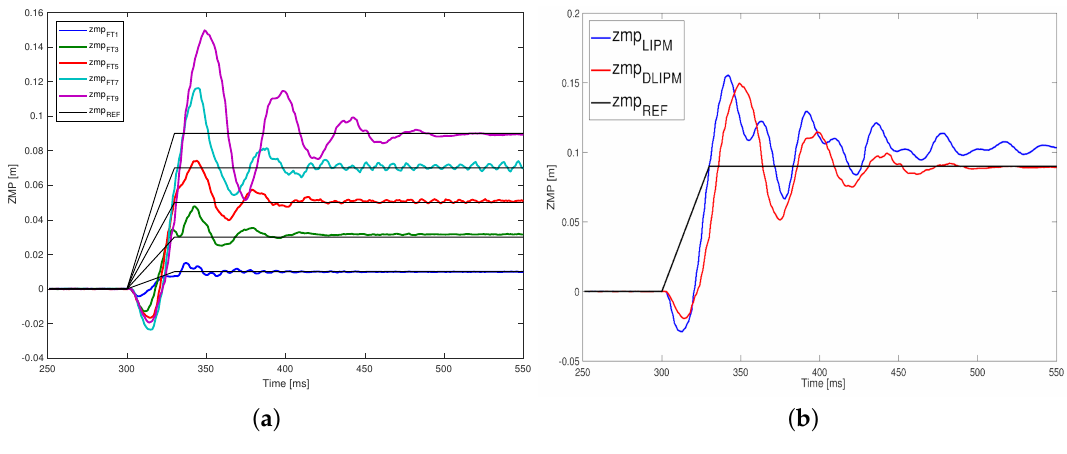
Figure 21. Comparison of ZMP step responses. ( a ) Step response experiments on DLIPM; ( b ) Comparison between the LIPM and DLIPM for ZMP = 9